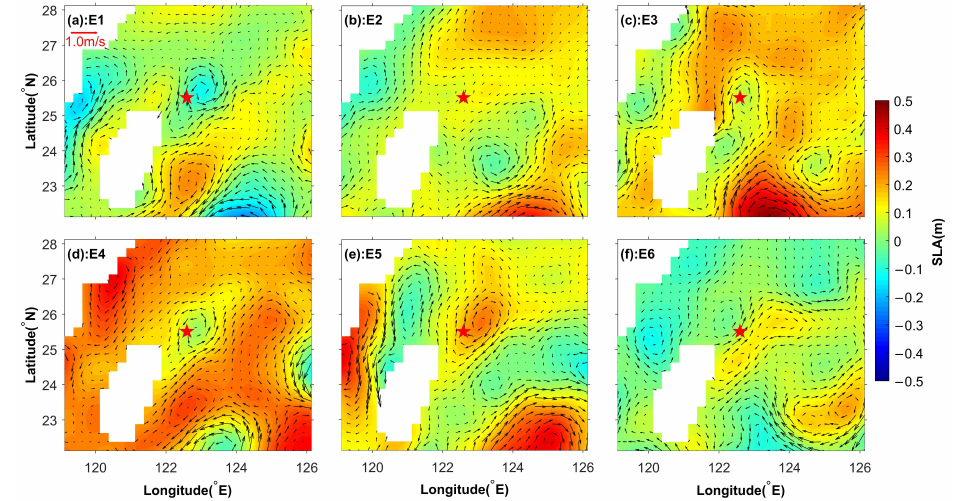
Figure 14. Sea level anomaly (color) and geostrophic current anomaly (arrow) during episodes 1 to 6 according to AVISO